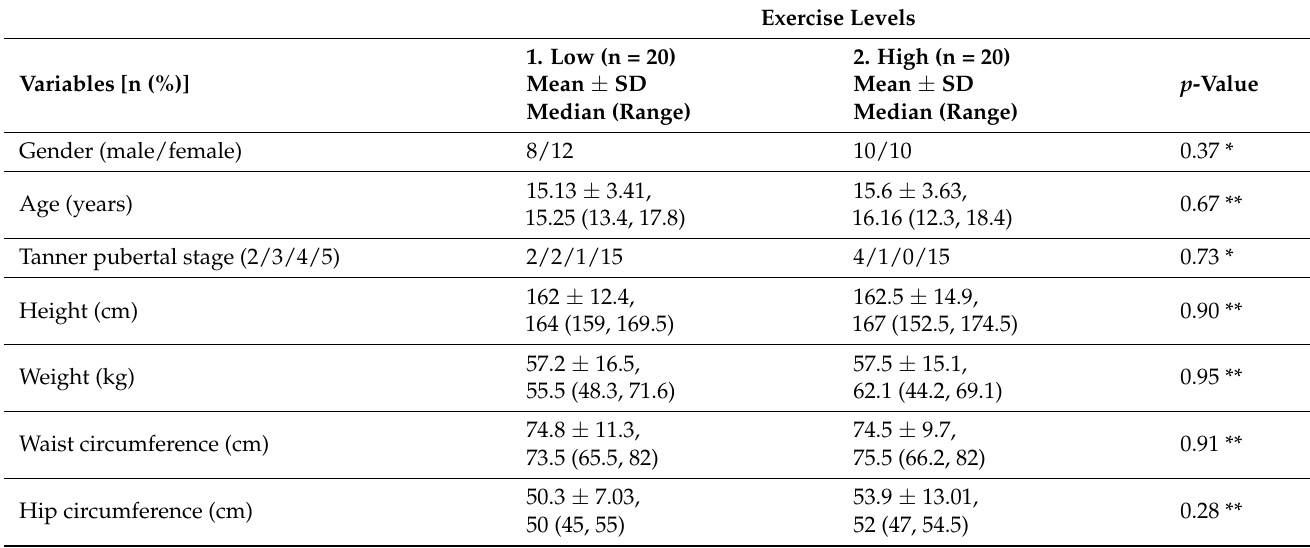
Table 2. Basic demographic, clinical and biochemical parameters of the study population according to the extreme exercise levels